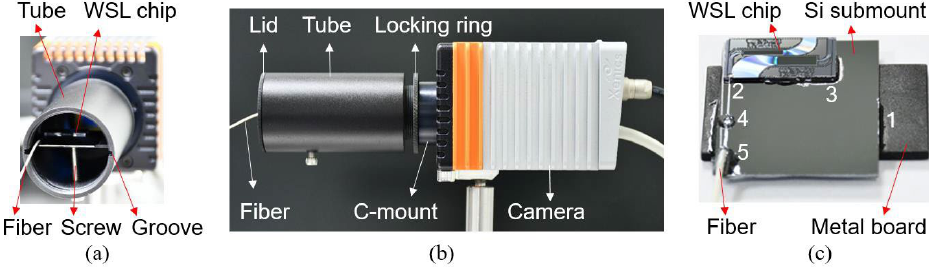
Figure 16. ( a ) Inside view of a tube holding a WSL chip. ( b ) Side view of the tube mounted to a C-mount camera. ( c ) Photo of the WSL chip fixed on a silicon submount and a metal board. The labeled numbers indicate the order of UV curing.